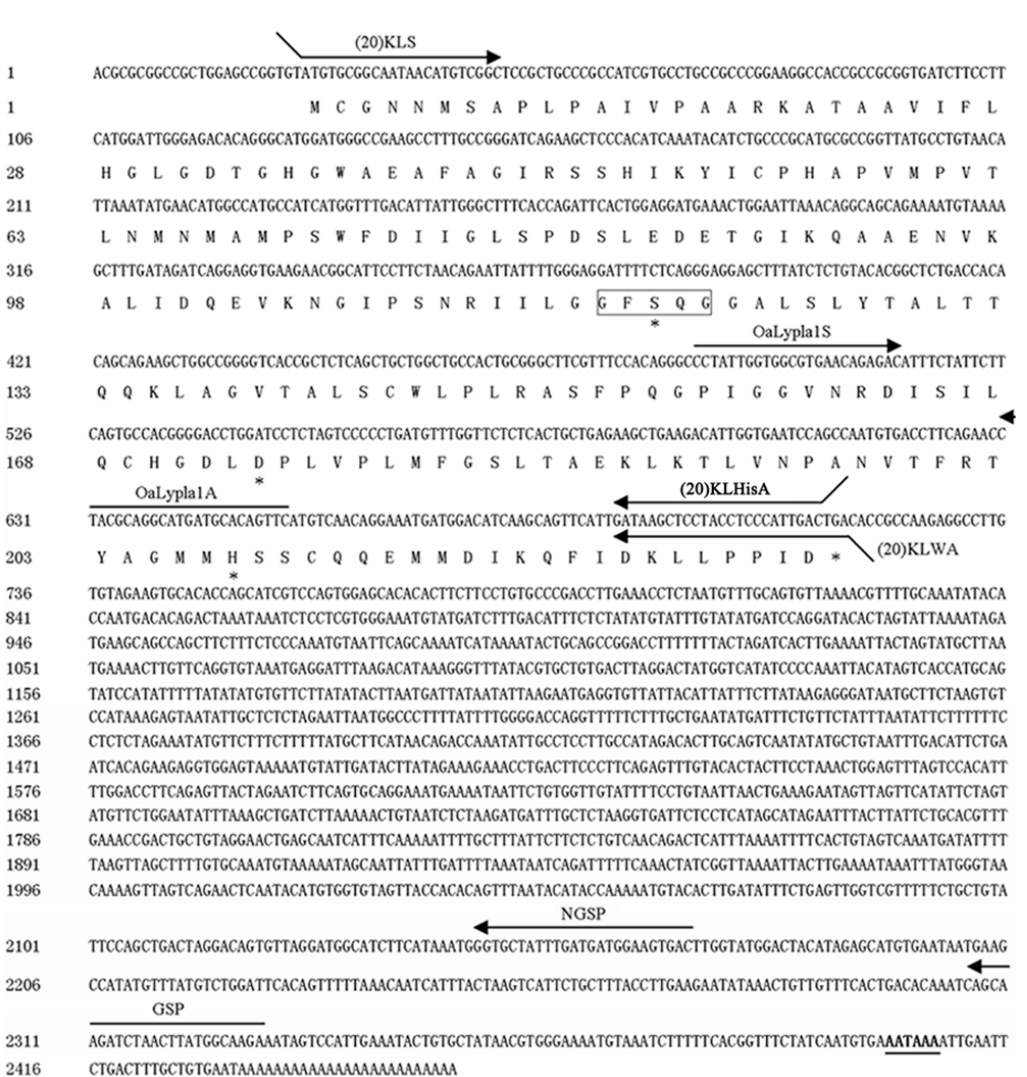
Figure 1. The full-length cDNA and the corresponding amino acid sequence of OaLypla1 . The polyadenylation signal sequence (AATAAA) is shown in bold and underlined. The lipase motif GXSXG is boxed, and the catalytic triad is marked by asterisks (*). The arrows represent the places and lengths of the primers (5’-3’) used in this study.